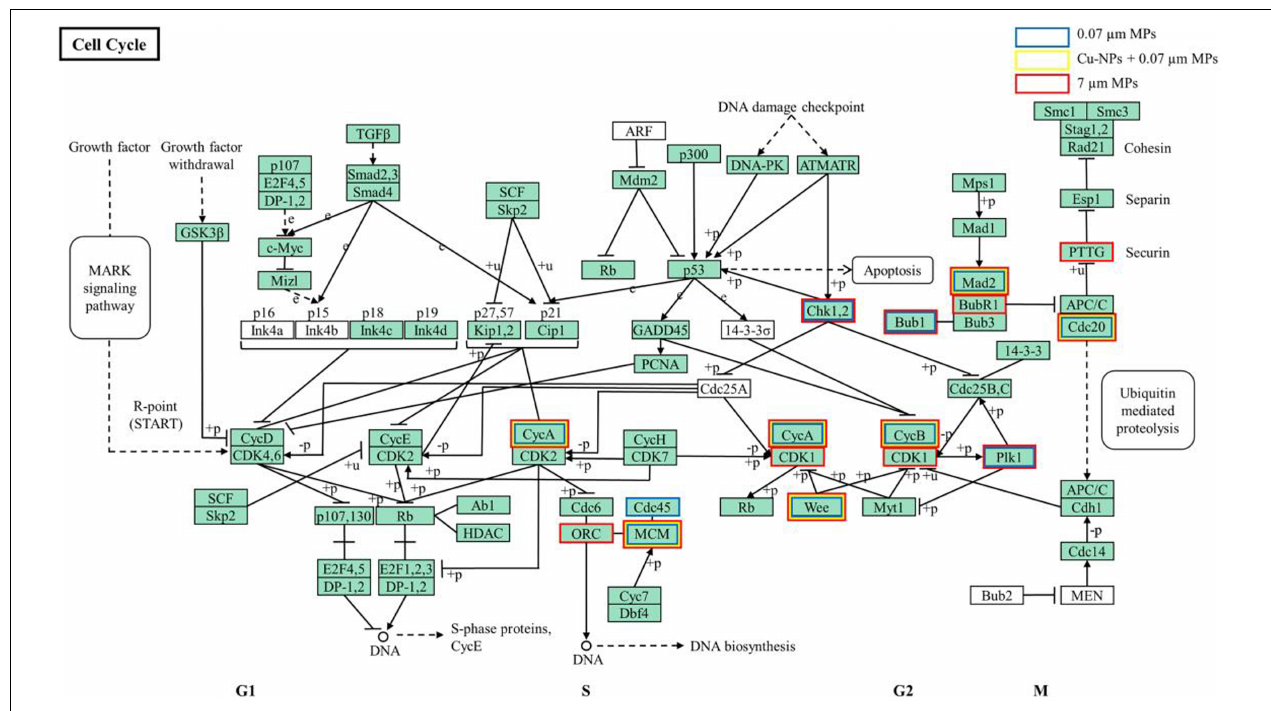
FIGURE 6 | Cell cycle. Blue, red and yellow boxes represent the DEGs of zebrafish under 0.07 µ m MPs, 7 µ m MPs and Cu-NPs + 0.07 µ m MPs treatments,